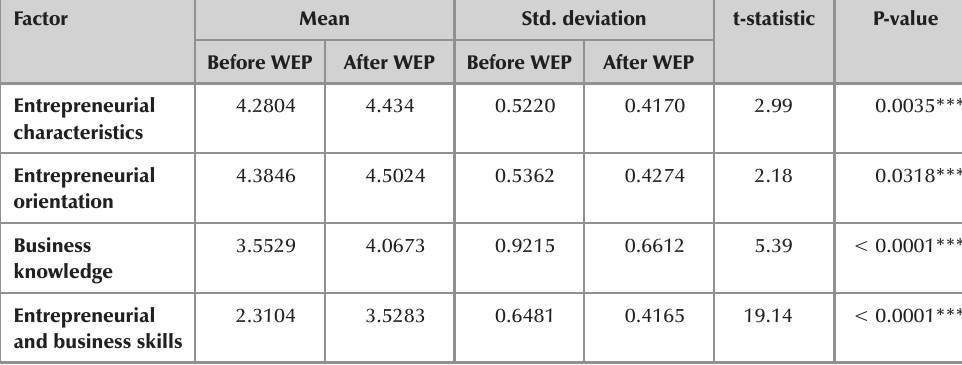
Paired sample t-test: Comparison of the experimental group before and after the WEP on the four skills transfer factors Factor Mean Std.